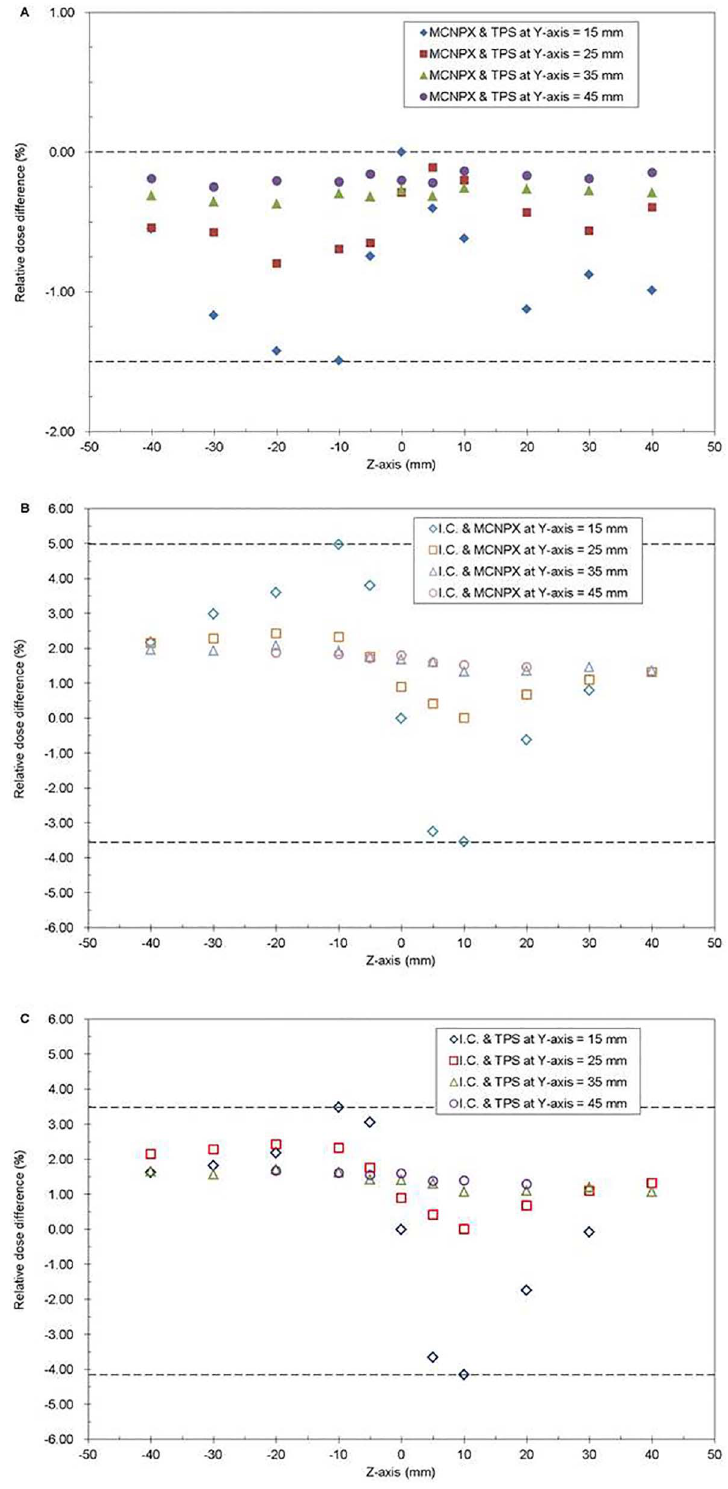
Figure 5. Relative dose differences in water with the presence of the tandem. (a) MCNPX-calculated value versus treatment-planning value, (b) MCNPX-calculated value versus ionization-chamber-measured value, and (c) treatment-planning value versus ionization-chamber-measured value.